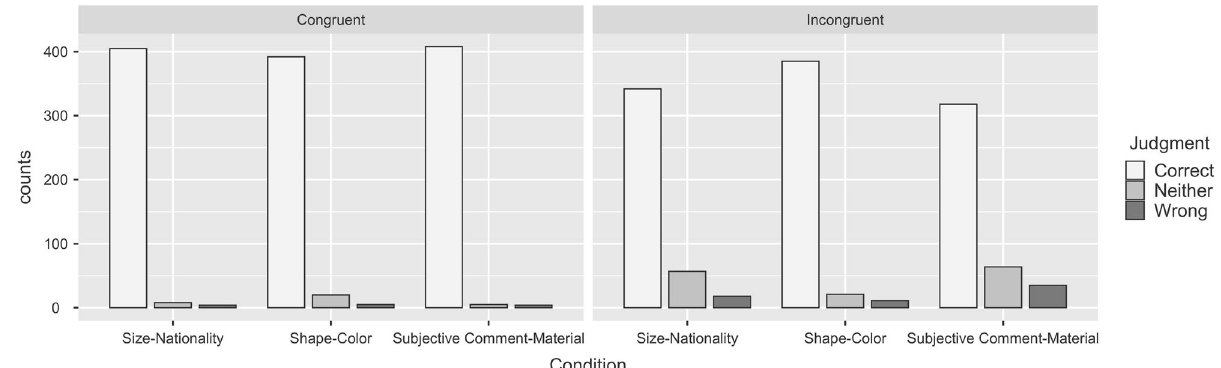
Fig. 2 Judgments split by order and condition. The bars show raw scores.